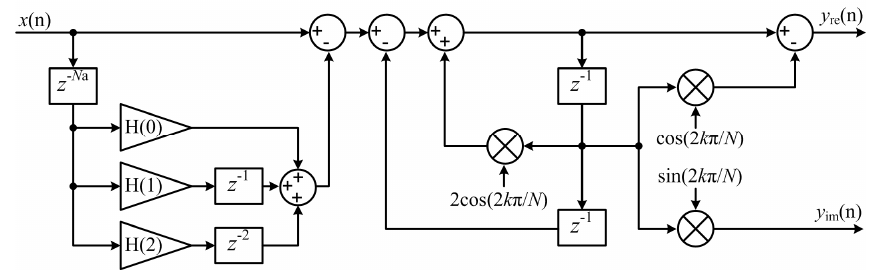
Figure 5. The improved structure of SGDFT.